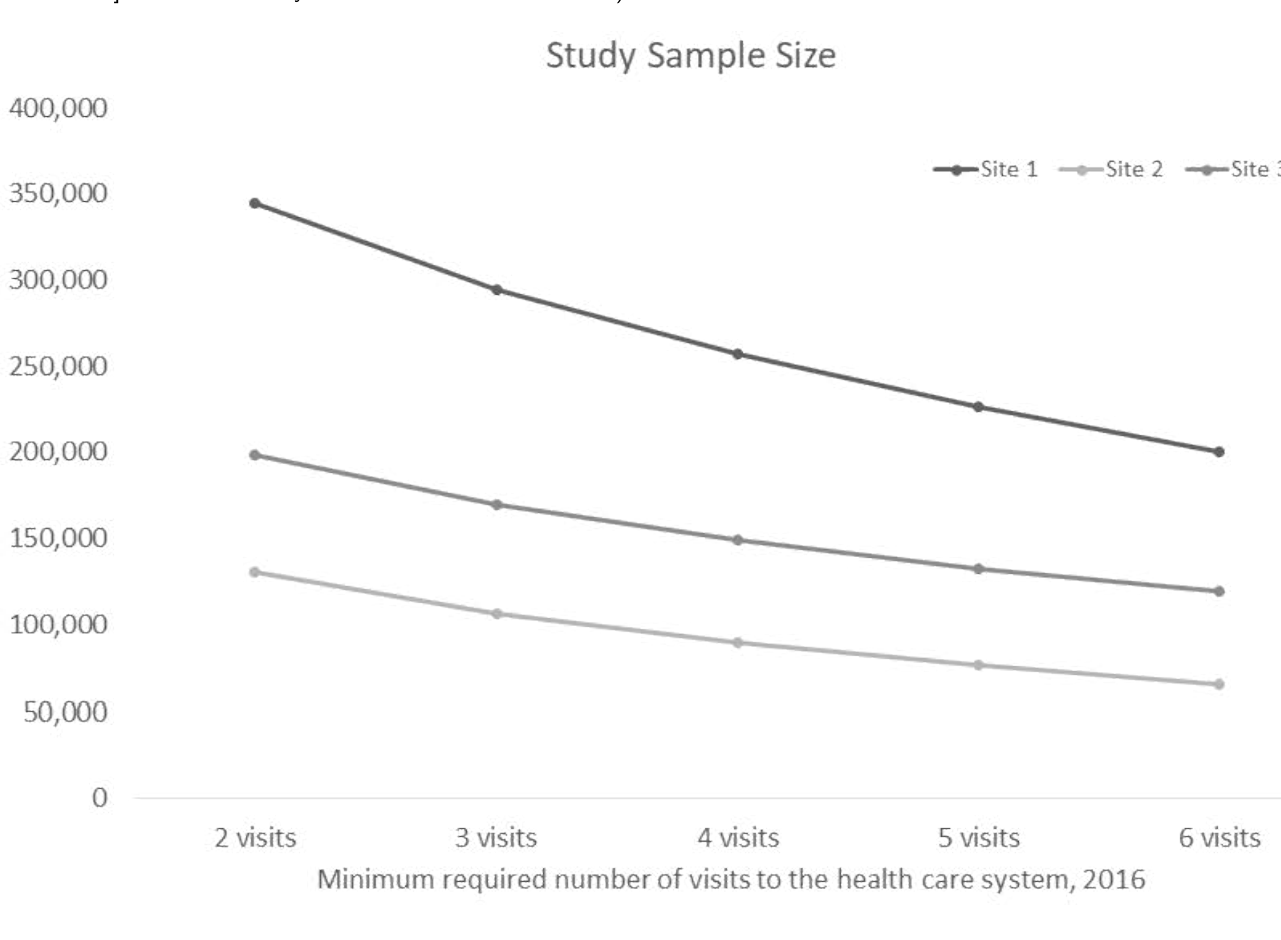
Figure 1: Study sample for each health system for different minimum required number of visits ([inpatient, outpatient, or emergency room visits] from 1st January 2016 to 31st December 2016)